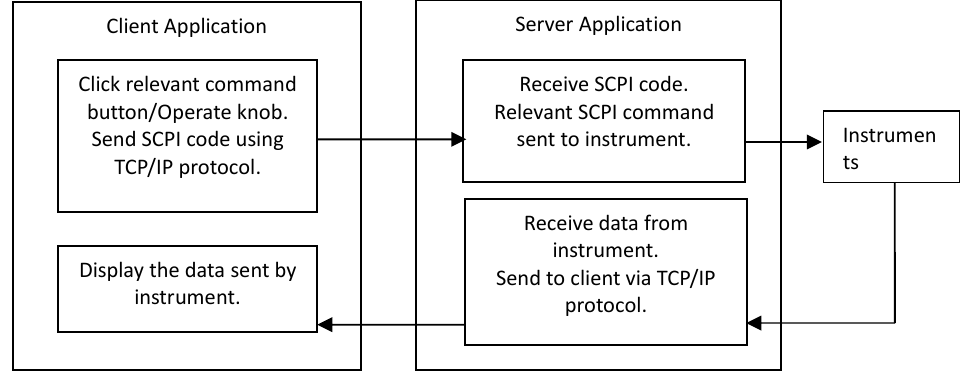
Figure 2 Instrument control architecture of the ORL